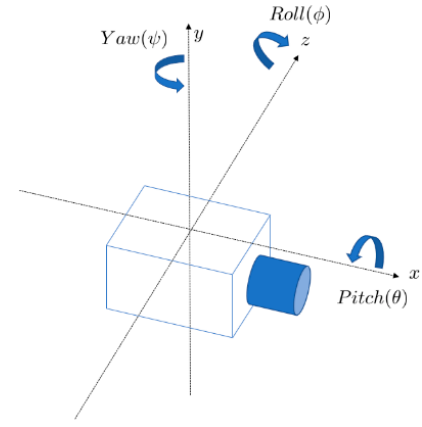
Figure 3. Camera coordinate system.